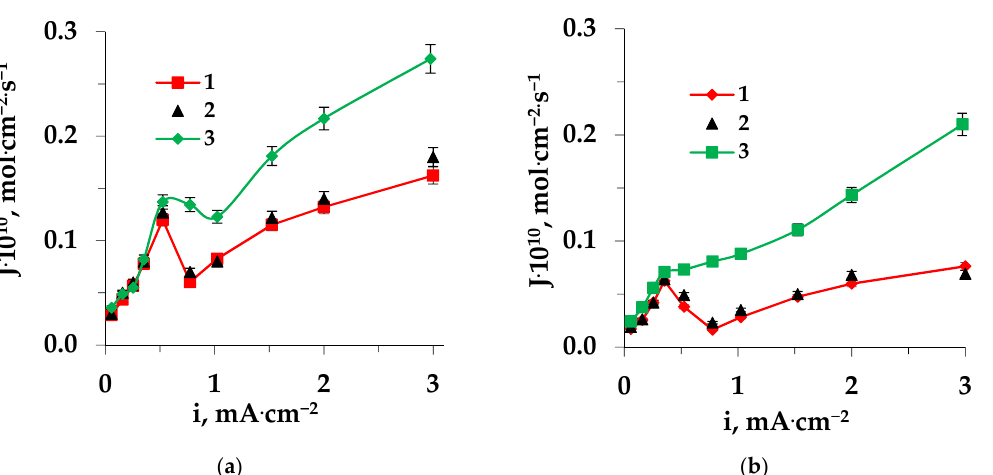
Figure 7. Dependences of amino acid fluxes through the MK-40 ( a ) and MA-41 ( b ) membranes on the current density during electrodialysis of Trp + NaCl solution: 1—pristine membrane, 2—regenerated membrane, and 3—fouled membrane.